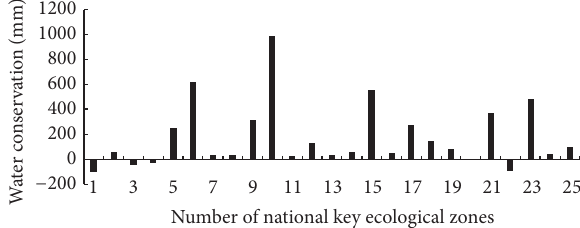
Figure 6: Mean water conservation of observation in NKEFZ (the number can refer to Figure